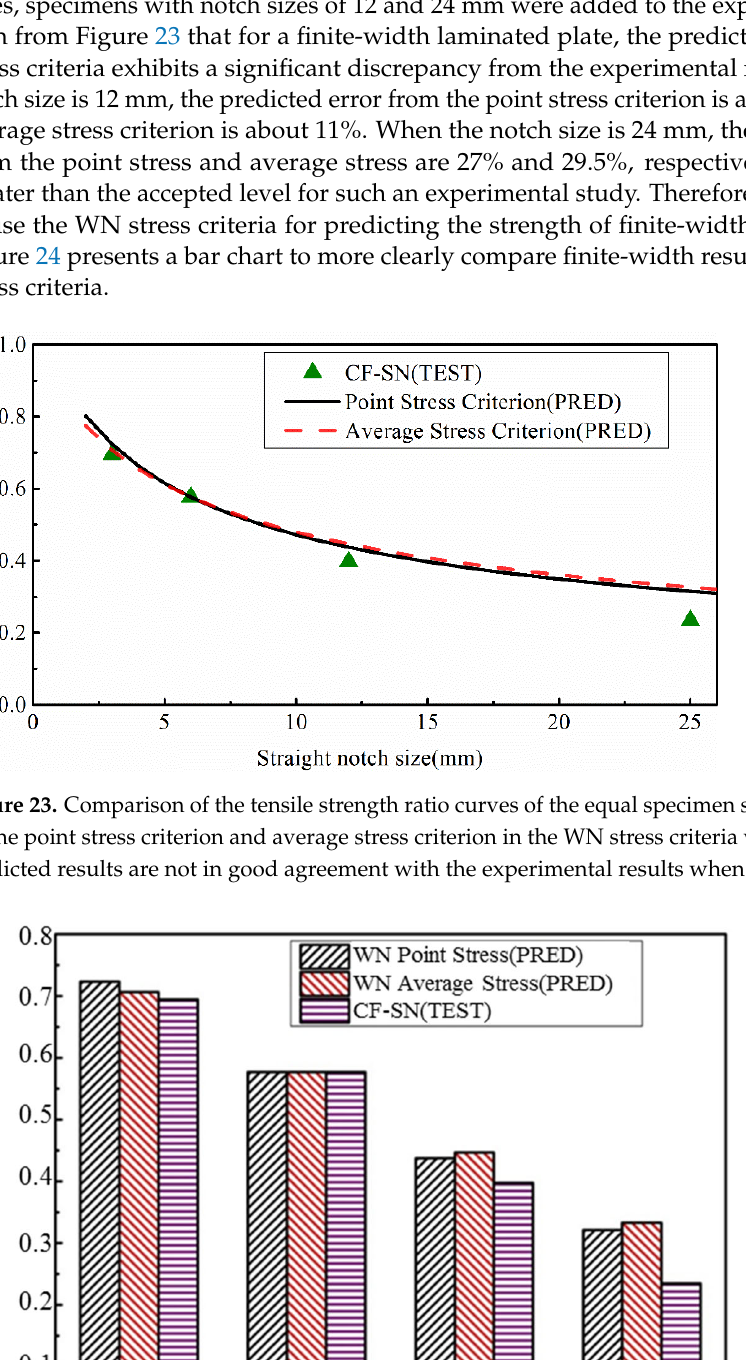
Figure 22. Comparison of the tensile strength ratio curves of the equal 𝑊 /2 𝐶 ratio group predicted by the point stress criterion and average stress criterion in the WN stress criteria with test results; it meets the curve of the test results well.